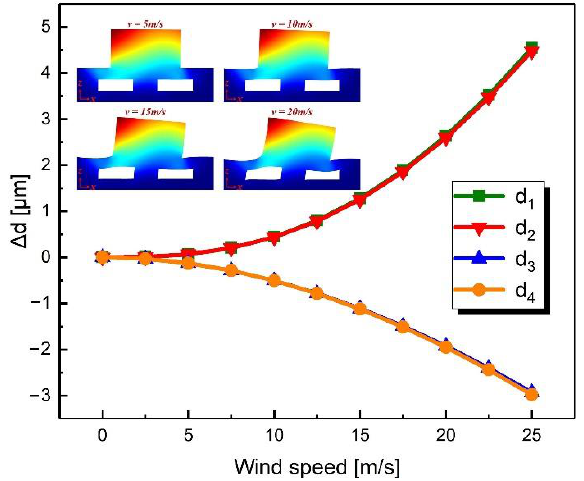
Figure 3. Simulated change in gap distances when the wind speed varied from 0 m/s to 25 m/s in the xy-plane with a fixed direction of 0°.